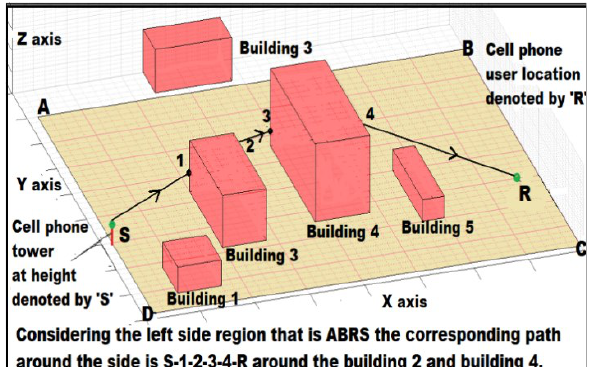
Figure 7. A signal path around the left side of the building(S.